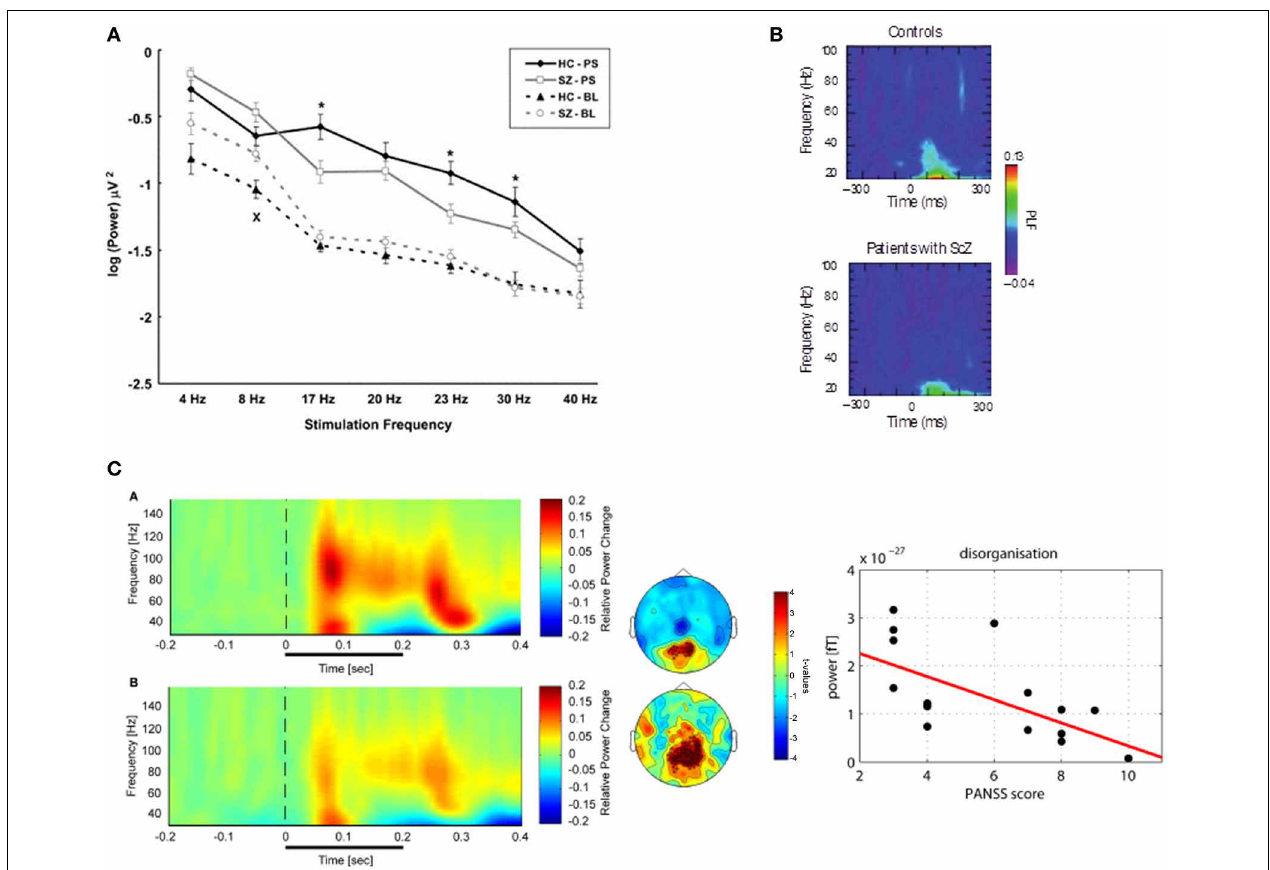
FIGURE 1 | (A) Visual steady-state potentials (SSP) in patients with schizophrenia and controls: Average signal power for the two groups during resting state and photic stimulation at different frequencies recorded at Oz. (Legend: HC-PS, healthy control subjects during Photic Stimulation; SZ-PS, Schizophrenia subjects during Photic Stimulation; HC-BL, Healthy control subjects during Baseline; SZ-BL, Schizophrenia subjects during Baseline). Error bars indicate standard error. Significant differences between groups on ANOVAs are marked with “ ∗ ” for the photic stimulation condition and “x” for the resting condition. Adapted from Krishnan et al. (2005). (B) Sensory evoked oscillations during a visual oddball task in patients with schizophrenia. The colored scale indicates the phase locking factor (PLF) of oscillations in the 20–100Hz frequency range in the occipital cortex (electrode O1) for healthy controls and patients with schizophrenia. Control participants show an increase in phase locking for gamma oscillations ∼ 100ms after stimulus presentation. However, this is significantly smaller in patients with schizophrenia, indicating a dysfunction in early sensory processes. Adapted from Spencer et al. (2008). (C) High-Frequency Oscillations during Perceptual